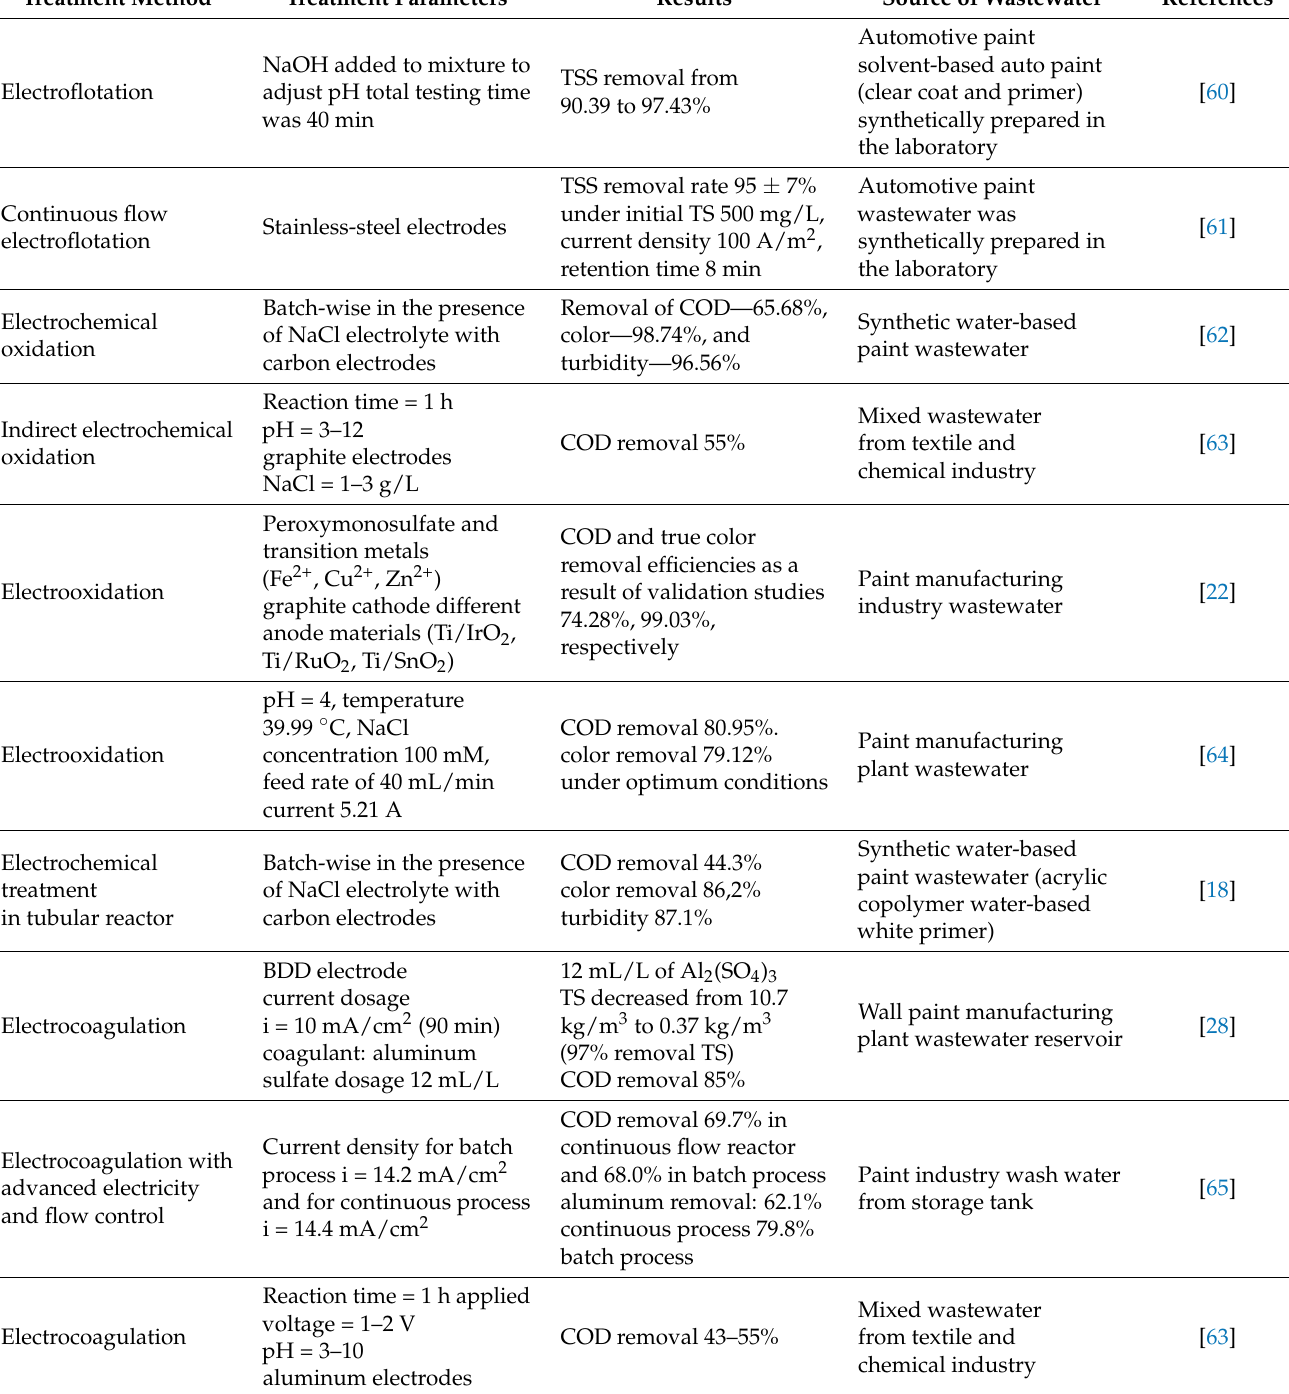
Table 3. Electrochemical treatment methods for paint industry